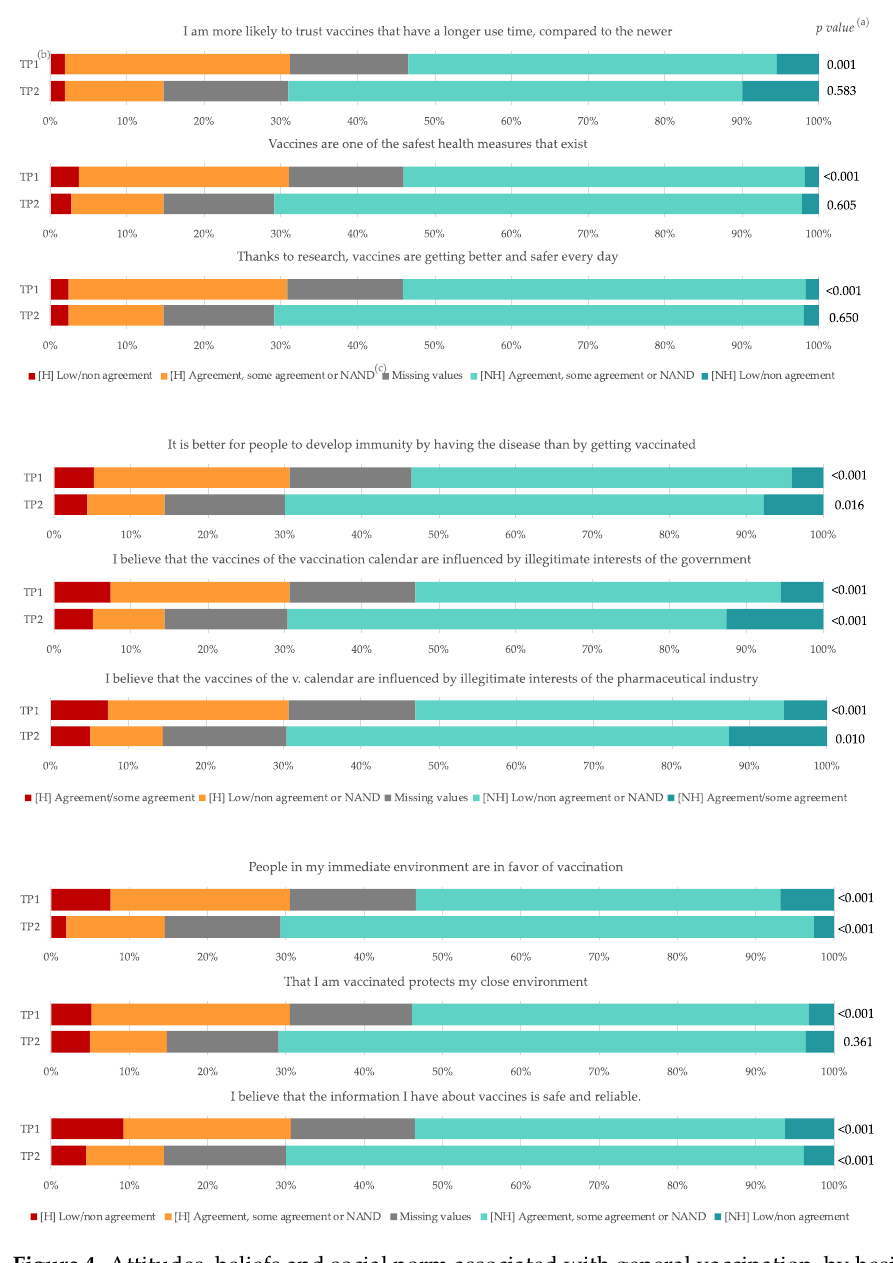
Figure 4. Attitudes, beliefs and social norm associated with general vaccination, by hesitancy and time point. COVID-19 Vaccine Hesitancy Study. Barcelona. 2020 – 2021. .(a) Chi square test does not include missing values. (b) TP = Time points 1 and 2. (c) NAND: neither agreement nor